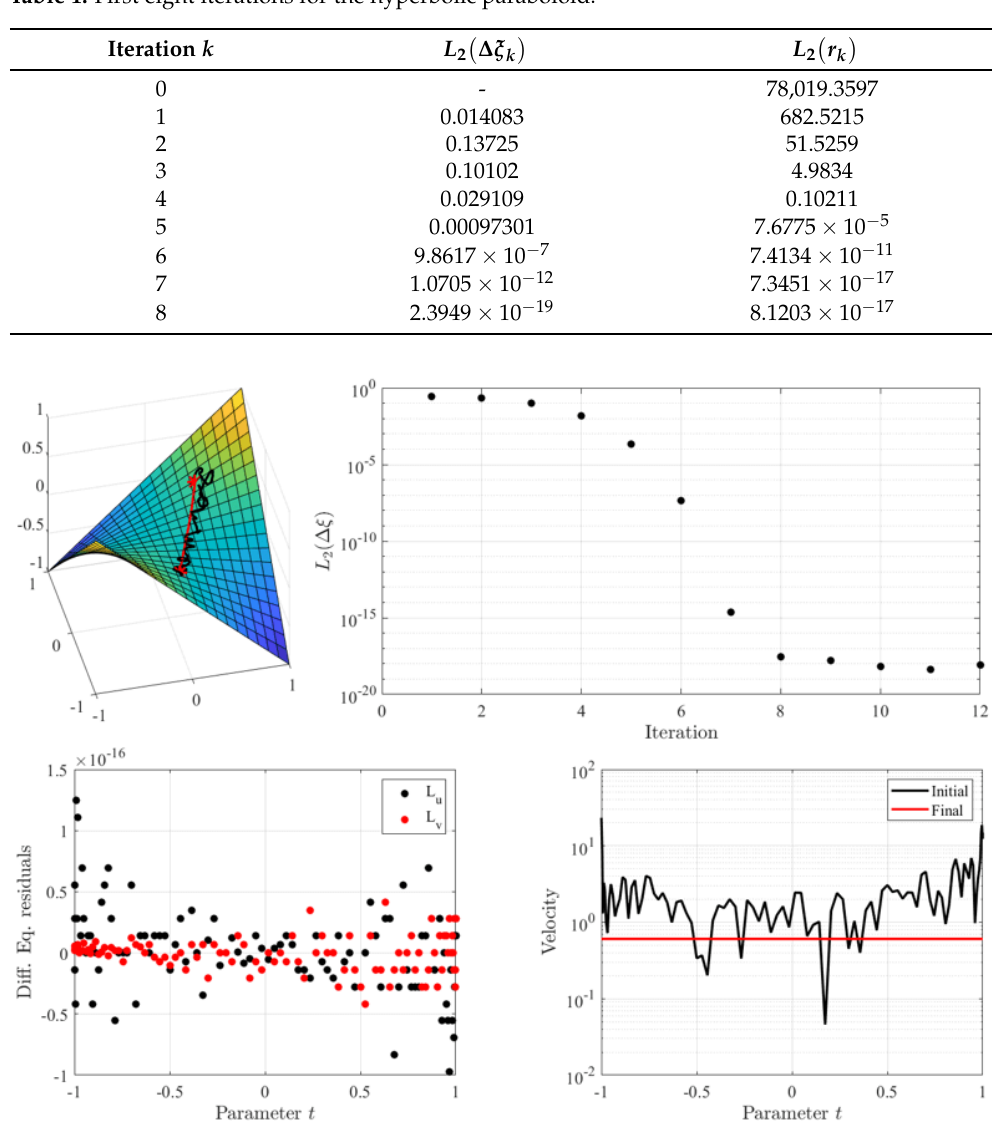
Figure 5. Hyperbolic paraboloid test